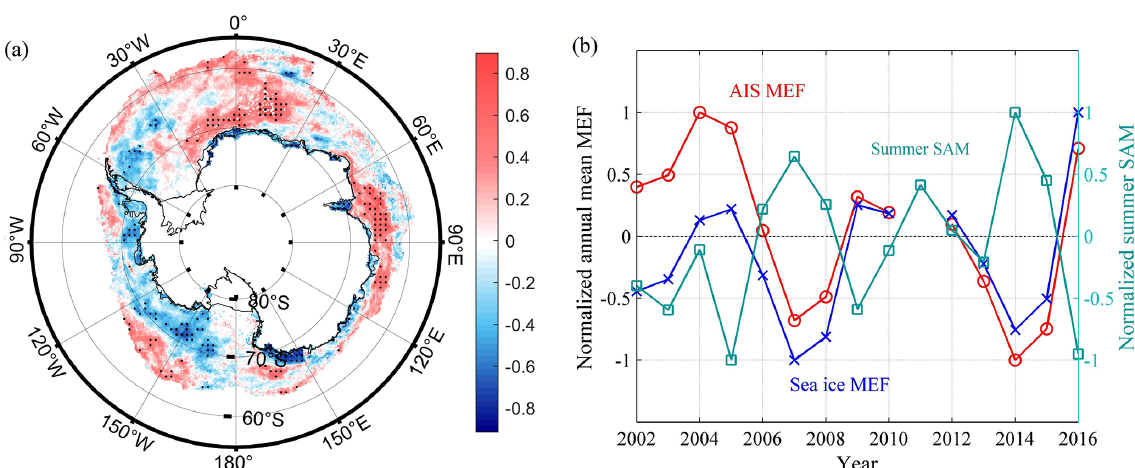
Figure 8. Linkage between pan-Antarctic region snowmelt and summer SAM. (a) Correlation coefficient between MDF and summer SAM; black points indicate the trends above the 90% confidence level. (b) Comparison of normalized summer SAM (cyan line), normalized annual mean Antarctic sea ice MEF (blue line) and AIS MEF (red